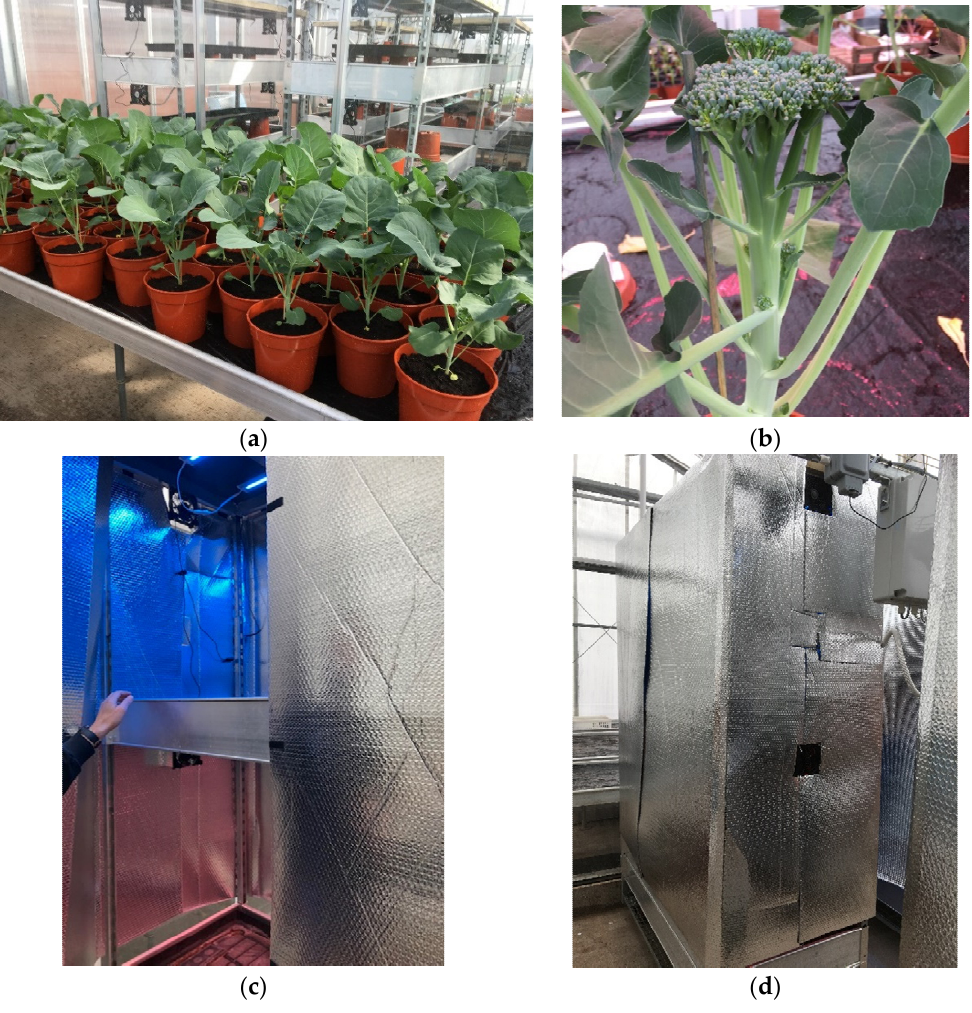
Figure 4. Images of the plants and lighting conditions. ( a ) Plants at week 8, trial 1, 19 April 2021, ( b ) central primary floret, week 12, trial 1, 13 May 2021, ( c ) LED lighting rack with blue LED lights on the top shelf and four-channel blue, white, red, far-red LED lights on the bottom; ( d ) LED shelving container when closed.